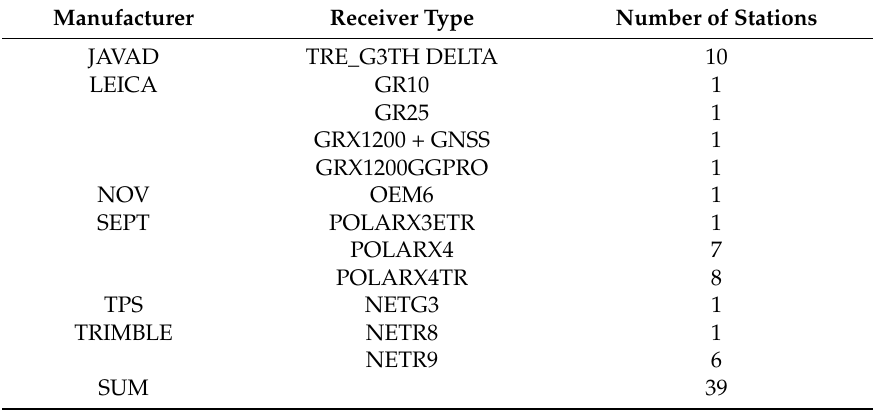
Table 2. Summary of Global Navigation Satellite Systems (GNSS) receivers of the selected